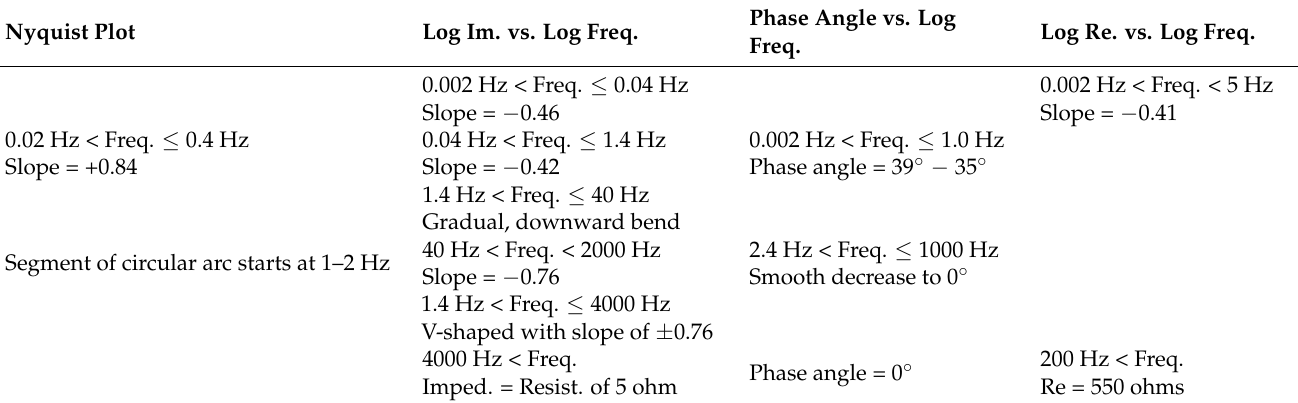
Table A4. Zn Test Summary of EIS at − 623